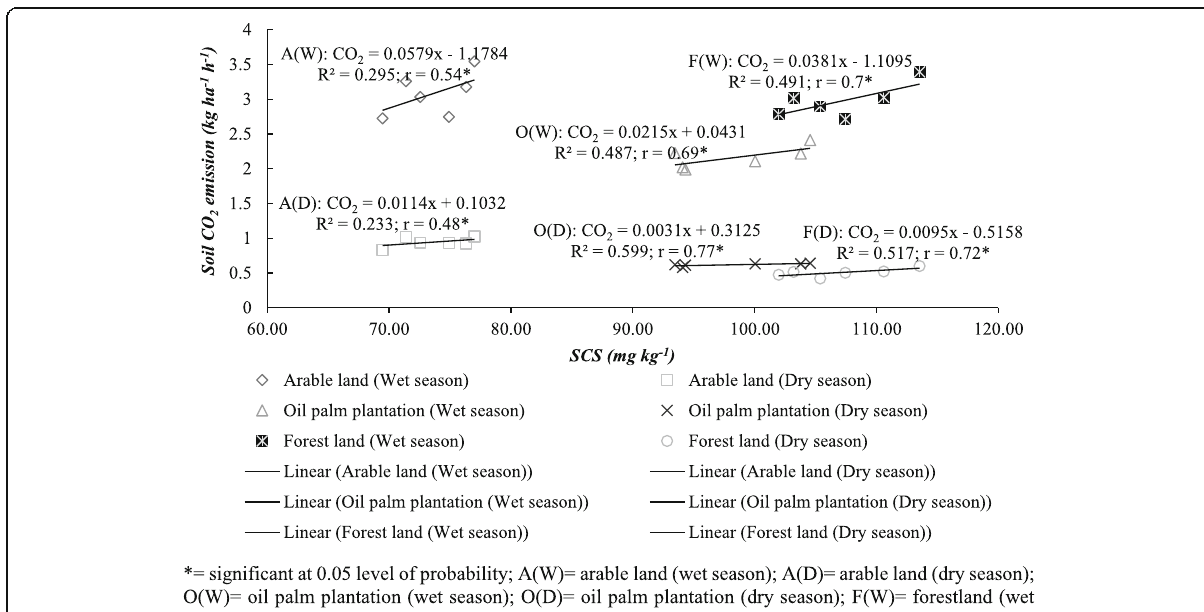
Fig. 6 Relationships between SCS and soil CO 2 production in the land-use systems for both